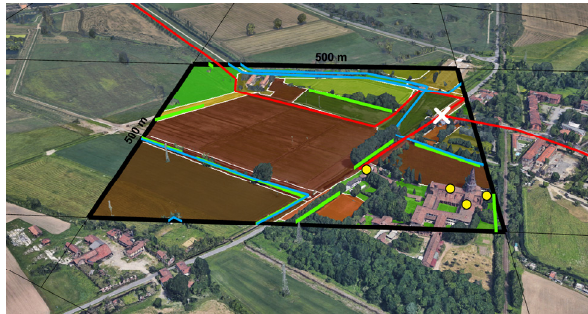
Figure 7. 3D interpretation of the Chiaravalle cell – score 7,5/10 Considering the whole routes, the “Sillari” route obtains the score 0,16, that means an average of almost 1 cultural heritage point per cell, that totally correspond to n.140 heritage points along the whole route. The “Lambro” route obtains the score 0,14, as cultural heritage density, that effectively correspond to a lower number of cultural heritage points along the route n.123. From the spatial distribution point of view, most of the cultural heritage points are concentrated in the urban settlements (Milano, Melegnano, Lodi Vecchio, Borghetto Lodigiano, Orio Litta), but some of them are spread over the countryside (Fig. 8).